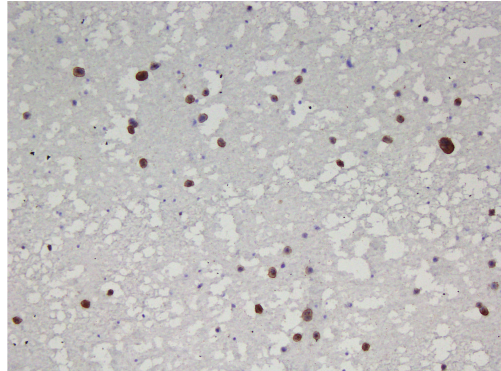
Figure 3: Positive CD138 immunostain obtained from fine needle aspiration of the laryngeal mass confirmed the presence of plasma